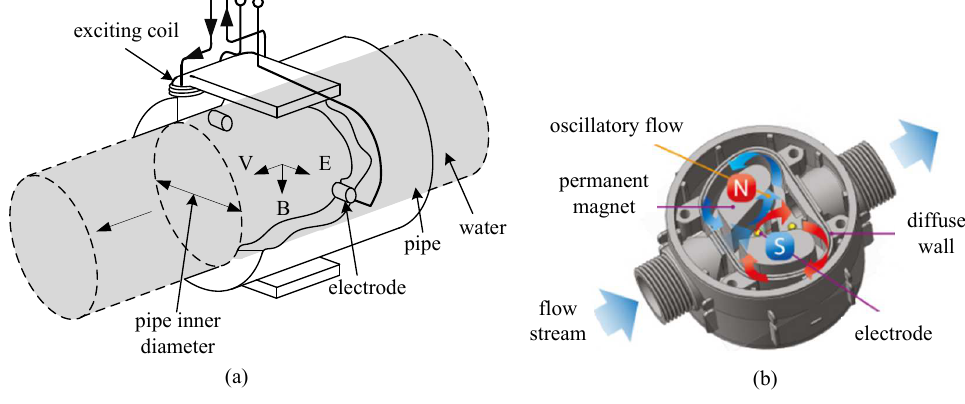
Figure 2. ( a ) electromagnetic meters; ( b ) fluidic effect